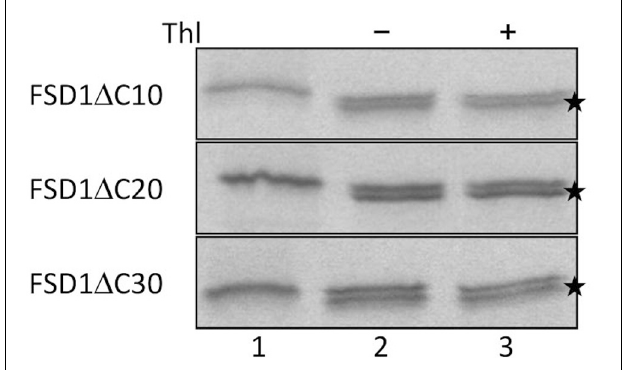
FIGURE 9 | The extreme C-terminus of FSD1 is not necessary for import. In vitro import assays into pea chloroplasts are shown. Lane 1 represents 10% of translation product, Thl ( + ) indicates thermolysin digestion after the import reaction (lane 3). Asterisks indicate lower bands probably arising from post-translational modifications such as processing of the first methionine. Representative results from n = 3 independent experiments are